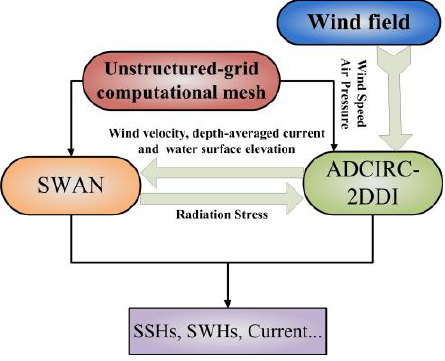
Figure 3. Schematic diagram of the ADCIRC+SWAN model. ADCIRC-2DDI: two-dimensional vertically integrated version of the ADCIRC; SWAN: Simulating WAves Nearshore.